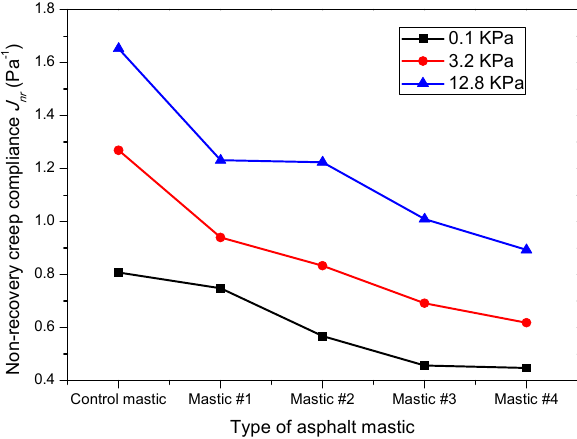
Control mastic Mastic #1